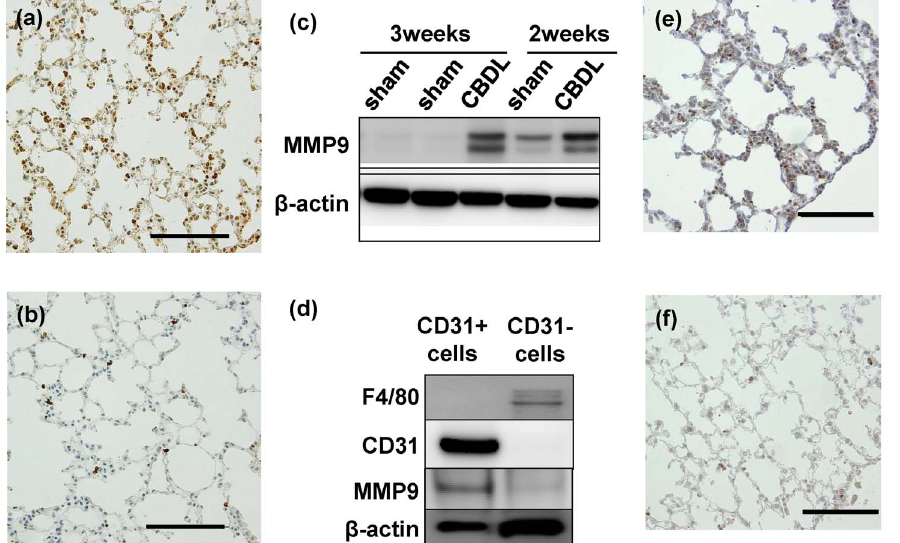
Figure 9. MMP8 and MMP-9 expression in mice 3 weeks after common bile duct ligation (CBDL). (a) Immunoreactivity of MMP-9 (matrix metallopeptidase) is stronger than that in sham-operated mice; (b) Immunohistochemical analysis. Scale bar =100 m m. (c) Immunoblotting of MMP-9 in the whole pulmonary tissue of the sham and of the 2 and 3 weeks after CBDL groups revealed that MMP-9 is highly expressed in the 2 and 3 weeks after CBDL groups, compared with the expression in the sham groups. (d) Immunoblotting of F4/80, CD31, and MMP9 in the CD31-positive pulmonary cell lysates obtained 3 weeks after CBDL showed higher levels of MMP9 expression in pulmonary vascular endothelial cells compared with those of CD31-negative pulmonary cells. (e) Immunoreactivity of MMP-8 is stronger than that in sham-operated mice; (f) Immunohistochemical analysis. Scale bar =100 m m.